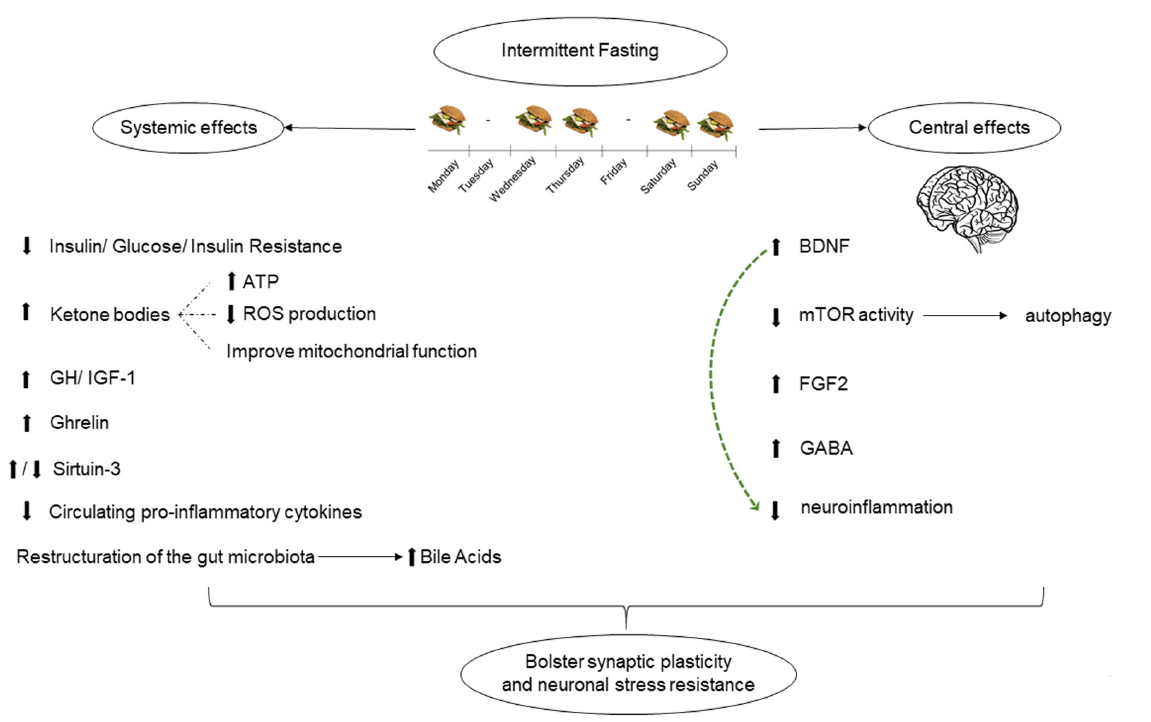
Figure 1. Summarizes the systemic and central effects of intermittent fasting, which ultimately confer neuroprotection. arrows pointing up, increased levels; arrows pointing down, decreased levels.